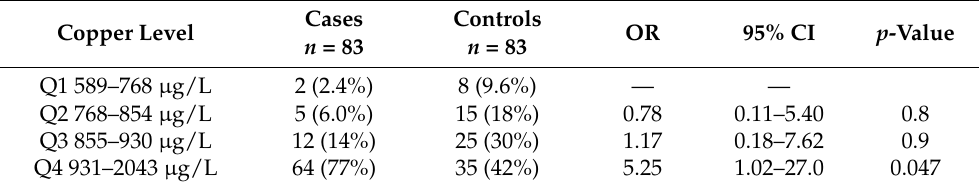
Table 3. Blood copper levels and the occurrence of colorectal cancer among women.